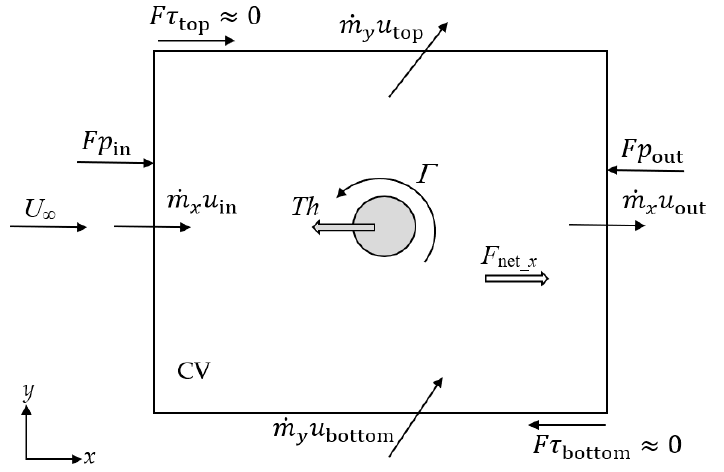
Figure 2. Schematic image showing the momentum transports and relevant forces in the x -direction of the control volume (CV) in the case of an isolated single rotor.